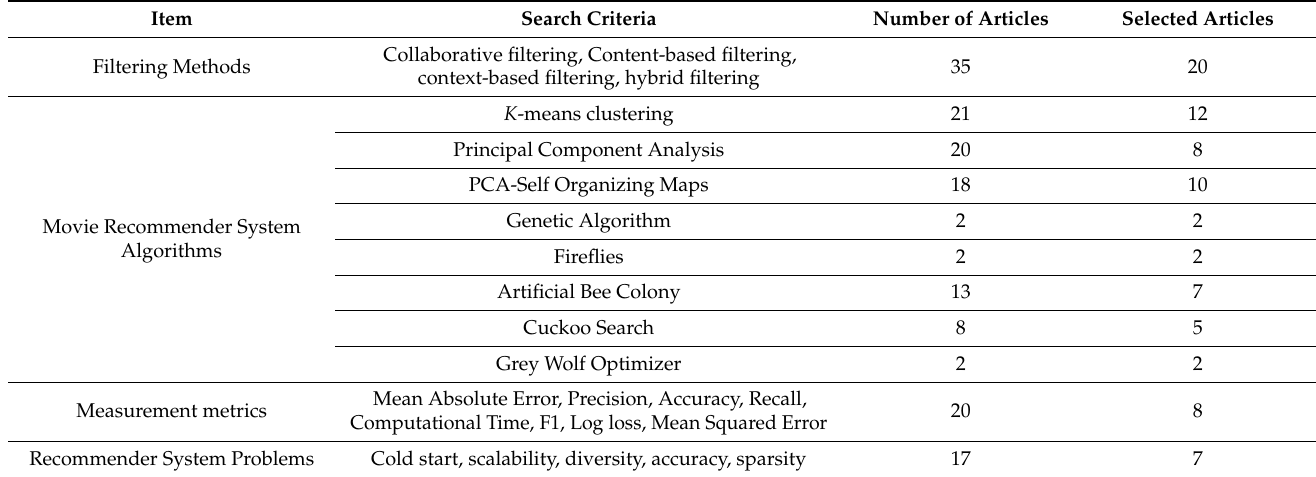
Table 1. Selection criteria for including sources in this review.